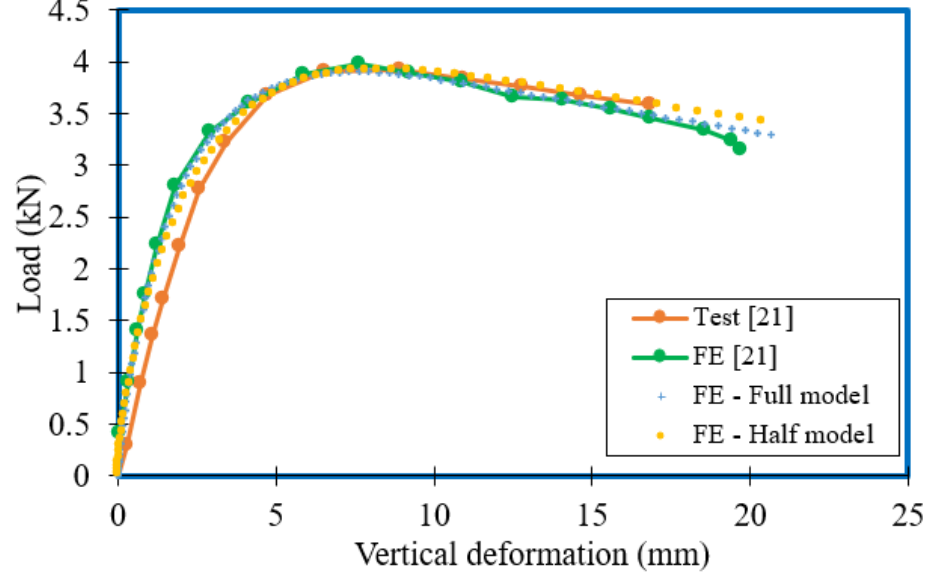
Figure 9. Load–vertical deformation comparison of ETF-UC15015 with 100 mm bearing plate [21].